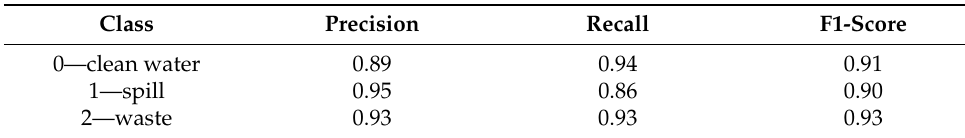
Table 3. Performance results for Experiment 1.